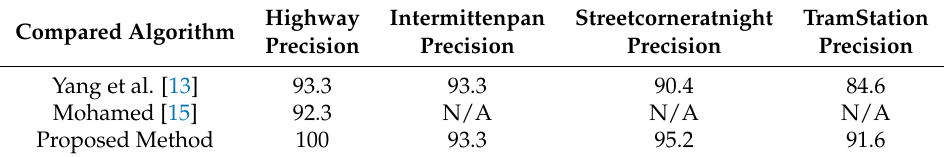
Table 6. Vehicle counting accuracy for CDnet2014 sequences.